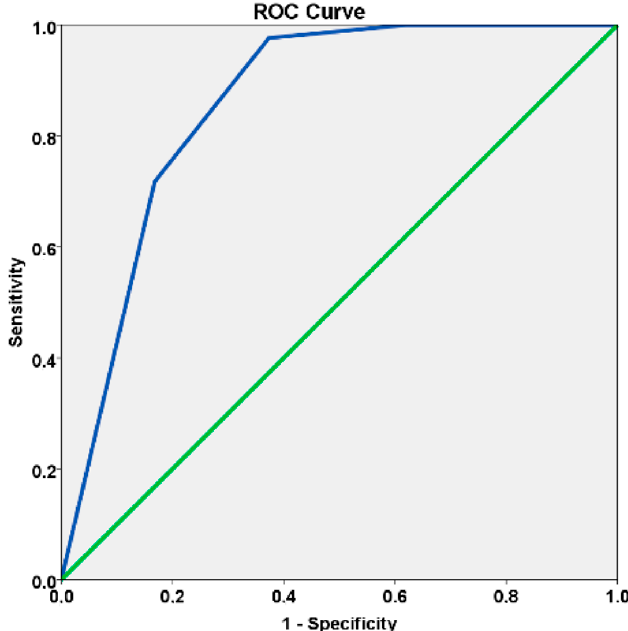
Figure 1. Receiver operating characteristic curve illustrating the performance of the risk algorithm (Area under the curve = 0.858, 95% confidence interval [0.820, 0.896], standard error = 0.019, p < 0.001, cut-off point =